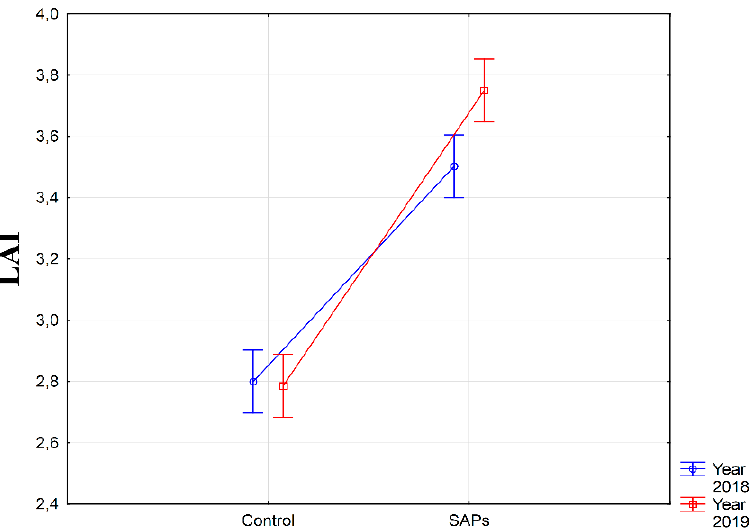
Figure 3. Interaction between experimental treatments and years for leaf area index (LAI). Figure was obtained at level of significance α = 0.01.